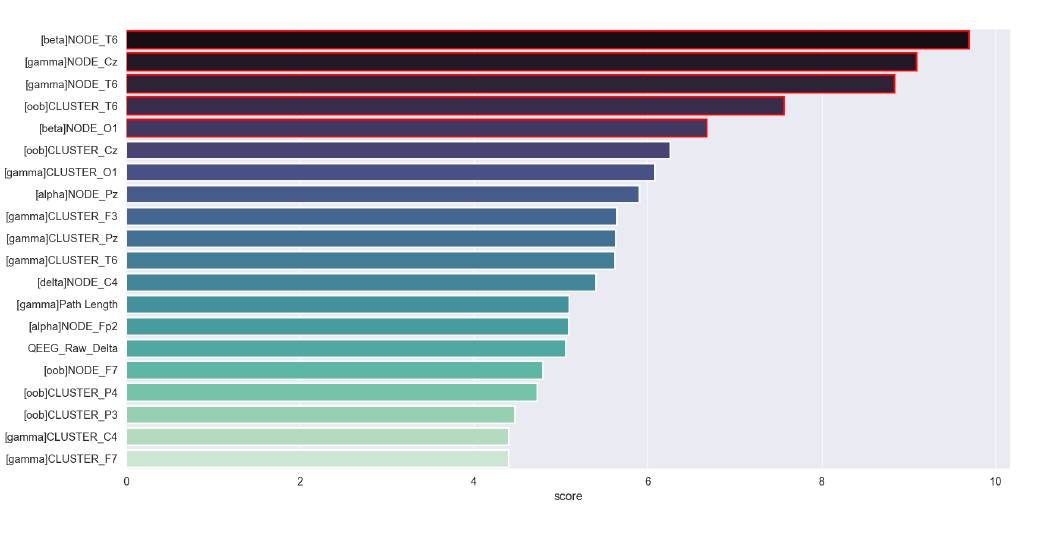
Figure 7. Representation of the 20 most important